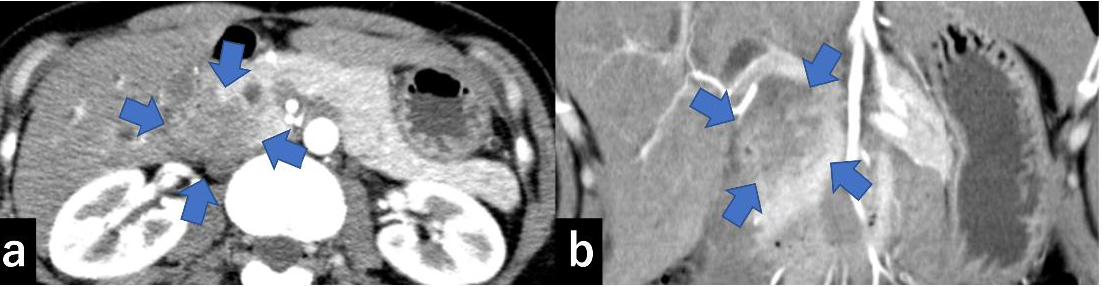
Figure 6. CECT shows a 30 mm large low-absorption area (arrow) in the pancreatic groove area ( a : axial, b : coronal). CECT, contrast-enhanced computed tomography. Type IV: Cases with a mass outside the groove region, pancreatic uncus, and the most caudal part of the pancreas (Figure 7).